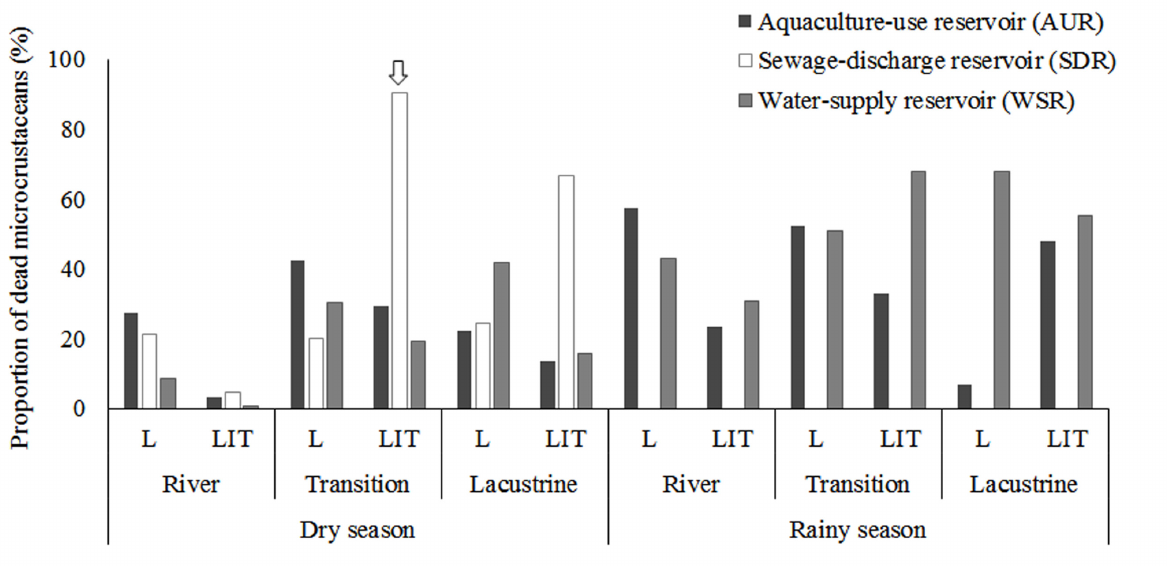
Figure 4. Percentages of microcrustacean mortality in three reservoirs in the neotropical semiarid ecosystems (Pernambuco, Brazil). Because of the reduced number of individuals (< 100 ind.) in the sewage discharge reservoir (SDR, white bars), it was not possible to calculate the proportion of dead microcrustaceans in the rainy season. L— Limnetic, LIT—Littoral. The arrow indicates the highest proportion of dead organisms